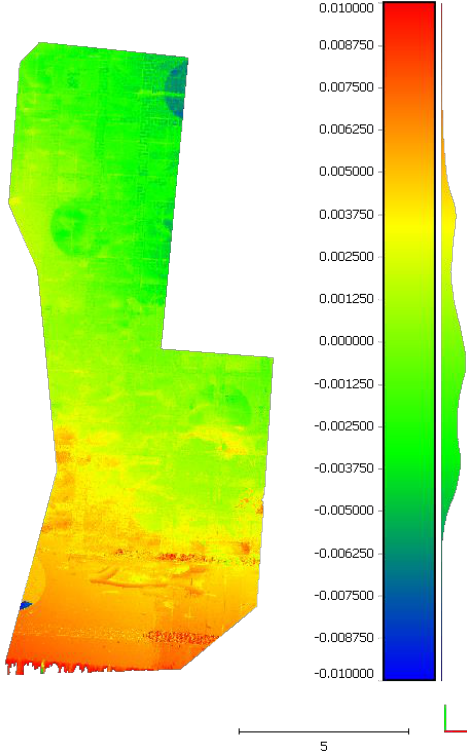
Figure 9. Z-coordinate differences between points clouds: point cloud only from TLS and merged TLS and image point